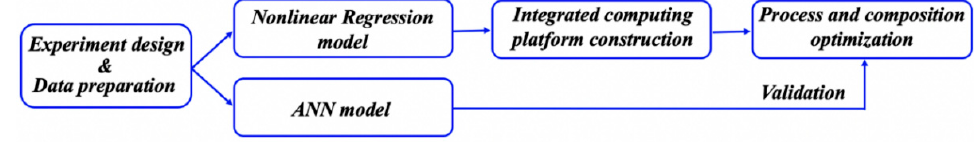
Figure 1. The flow chart of this work. Table 1. Chemical compositions of the experimental alloys (wt.%).